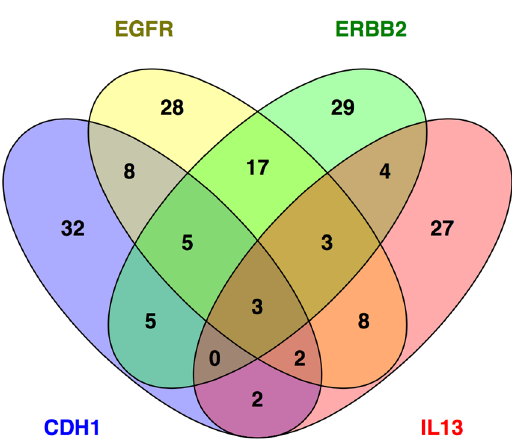
Figure 4. Common and unique genes networked with the 4 hub genes: EGFR, ERBB2, CDH1 and IL-13. Venn diagram illustrating common and unique genes that are networked with each hub gene in merged modules “P” and